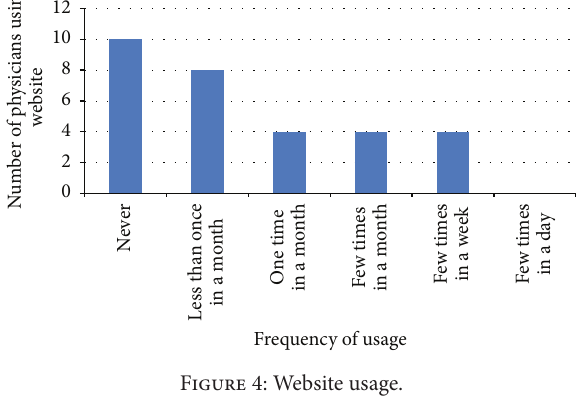
Table 4: Cronbach’s alpha and number of